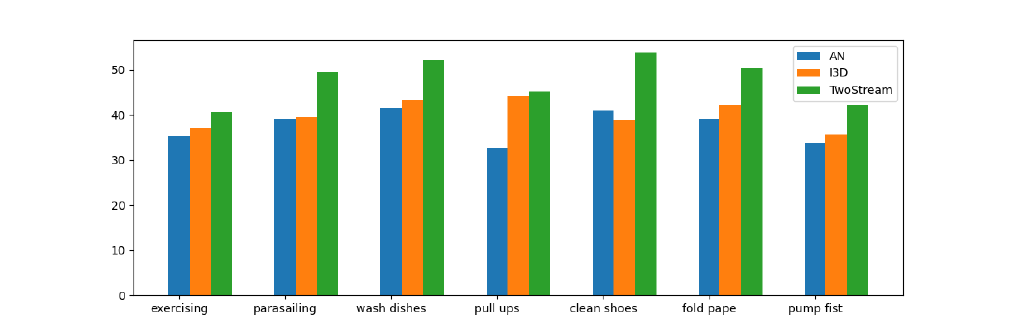
Figure 6. The prediction accuracy of different networks under different action types.